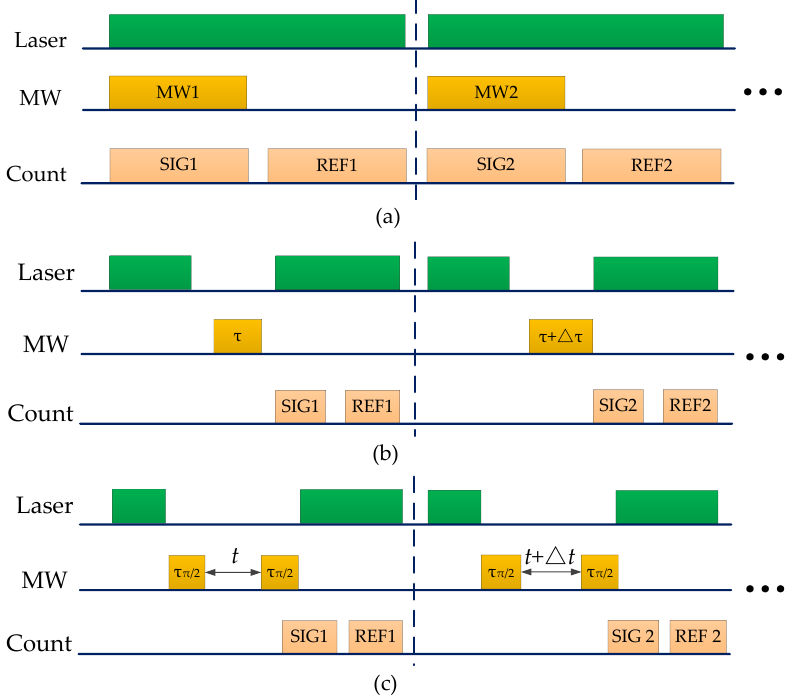
Figure 22. ( a ) ODMR measurement sequence. ( b ) Rabi measurement sequence. ( c ) Ramsey measure- ment sequence.